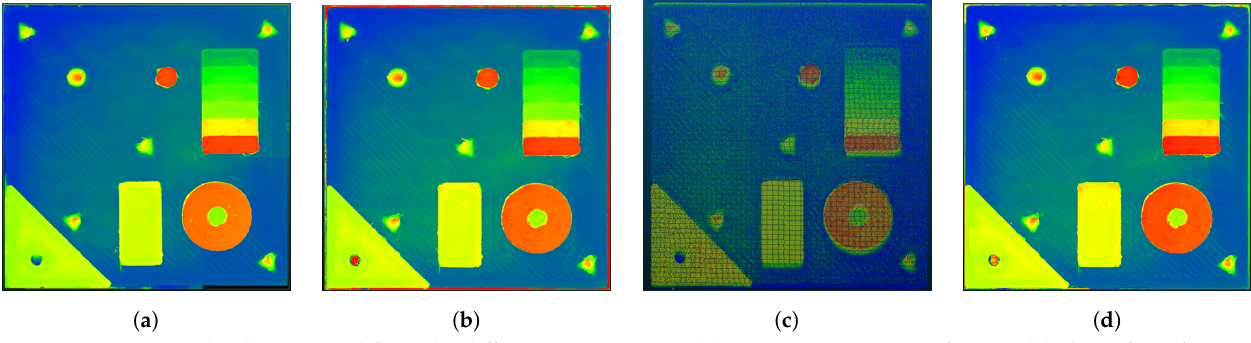
Figure 10. Point clouds generated from the different measurments ( a ) Keyence VK-X1000 reference, ( b ) shape from focus without thresholding, ( c ) laser triangulation, ( d ) shape from focus with thresholding from LT information.